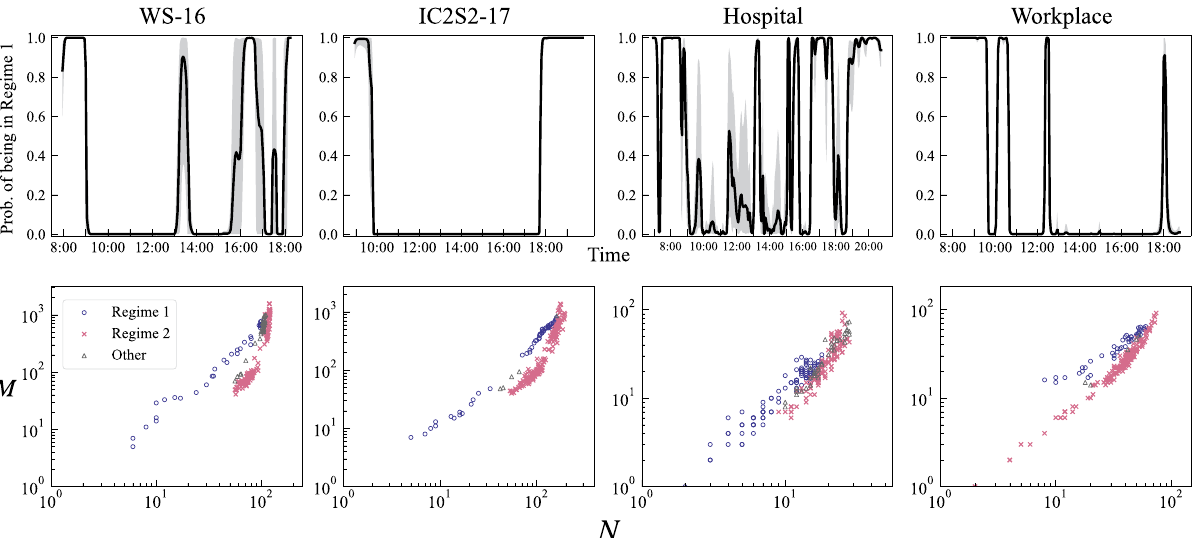
Figure 3. Identification of dynamical regime. Upper panels show the smoothed probability of being in Regime 1 (i.e., N p -driven dynamics) at each time window. 95 % credible interval is indicated by shading. Lower panels show N - M plots with classified regimes being denoted by different colours and symbols. We identify a snapshot network as being in Regime 1 (resp. Regime 2) if the estimated probability of being in Regime 1 (resp. Regime 2) is greater than 0.5 in more than 95 % of MCMC sampling. Otherwise, a network is considered as being in an undetermined “gray